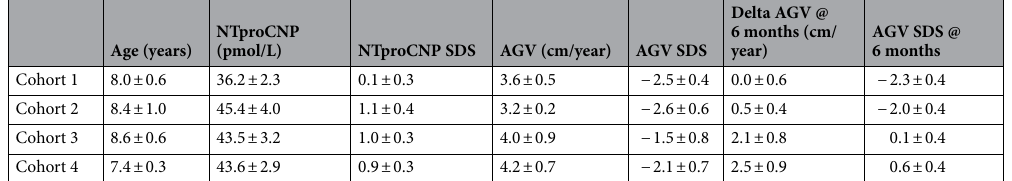
Table 1. Age, plasma NTproCNP and annualised growth velocity (AGV) at screening, and change (delta) at 6 months after commencing